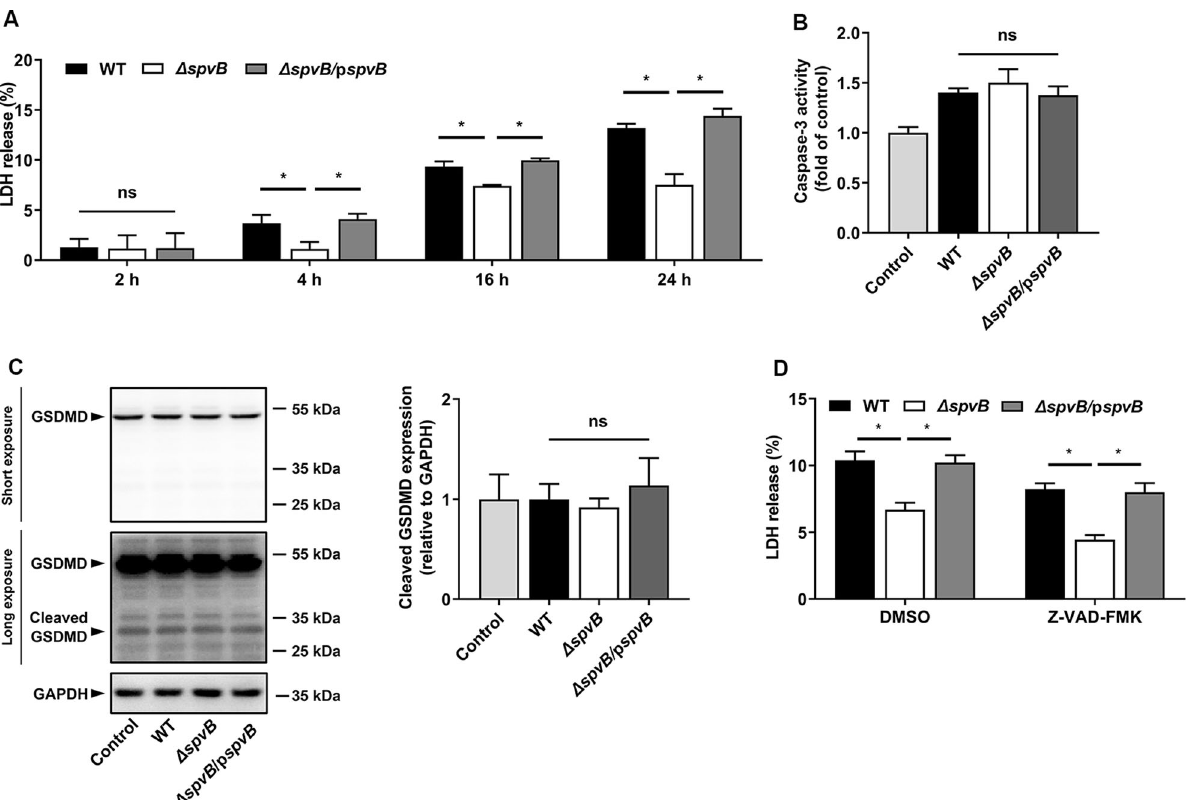
Fig. 1 Salmonella pSLT-encoded effector SpvB induces caspase ‐ independent cell death. A Caco-2 cells were infected with the WT, Δ spvB , or Δ spvB /p spvB S . Typhimurium strain (MOI of 100) and incubated for 2, 4, 16, and 24 h. Aliquots of cellular supernatants were subjected to LDH release assay. B , C Caco-2 cells were infected with the WT, Δ spvB , or Δ spvB /p spvB S . Typhimurium strain (MOI of 100) and incubated for 4 h. B Cells were harvested and subjected to measurement of caspase-3 activity. C Western blot analysis of the expression of cleaved GSDMD. D Caco-2 cells were treated with either vehicle (DMSO) or 20 μ M Z-VAD-FMK for 1 h. The cells were then infected with WT, Δ spvB , or Δ spvB /p spvB S . Typhimurium strain (MOI of 100) and incubated for 24 h. Aliquots of cellular supernatants were subjected to LDH release assay. Data were analyzed with IBM SPSS Statistics 19 and presented as the mean ± SEM using Student ’ s t -test and ANOVA with S-N-K correction. * P < 0.05; ns, not signi fi